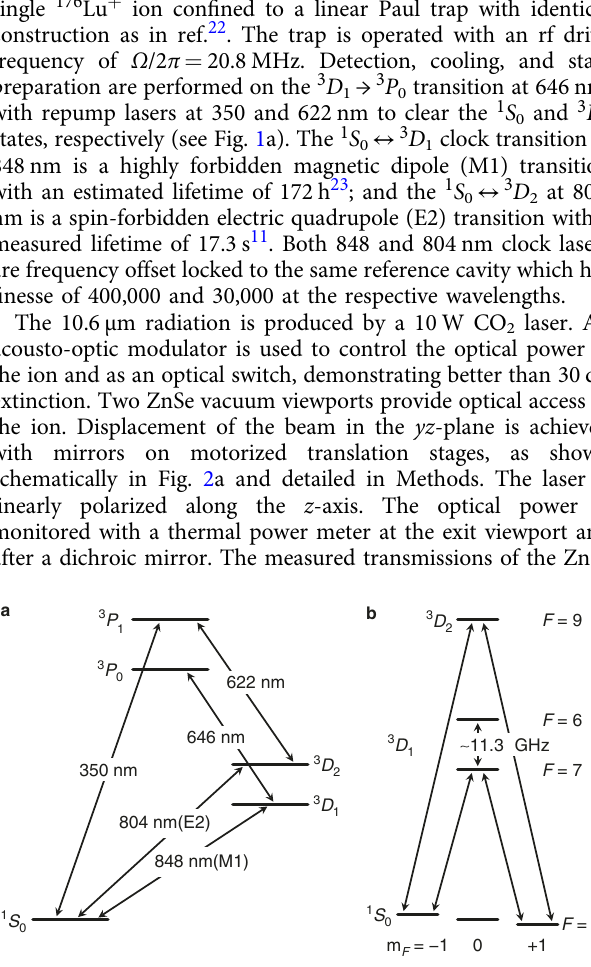
Fig. 1 Energy level structure of Lu + . a Low-lying energy levels showing the 804 and 848 nm clock transitions, 646 nm detection transition, and the 350 and 622 nm optical pumping transitions. b Hyper fi ne and magnetic substates for the clock transitions interrogated in this work, including the F = 7 to F = 6 microwave